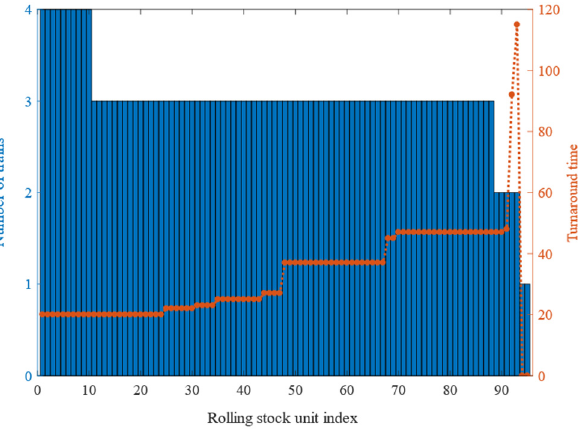
Figure 8. Number of trains served and average turnaround time of each rolling stock.